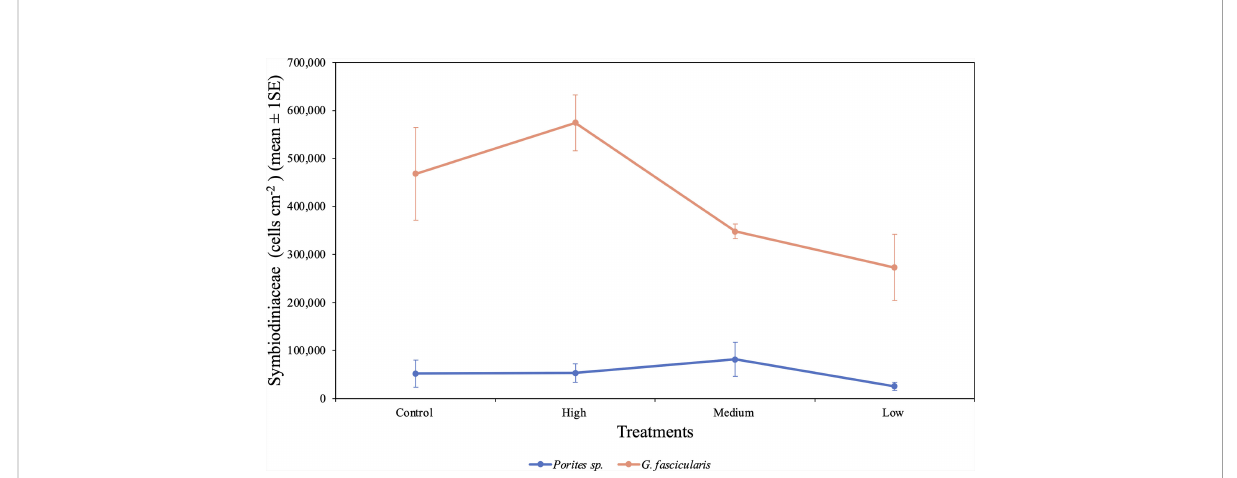
FIGURE 6 Mean (± 1SE) rates of Symbiodiniaceae cell density (cells cm − 2 ) for Porites sp. and G. fascicularis under all four O 2 treatments. Control and high O 2 treatment had a more signi fi cant cell density for G. fascicularis , while medium and low O 2 treatments presented a minor density. Porites sp. presented similar cell density between all four treatments.